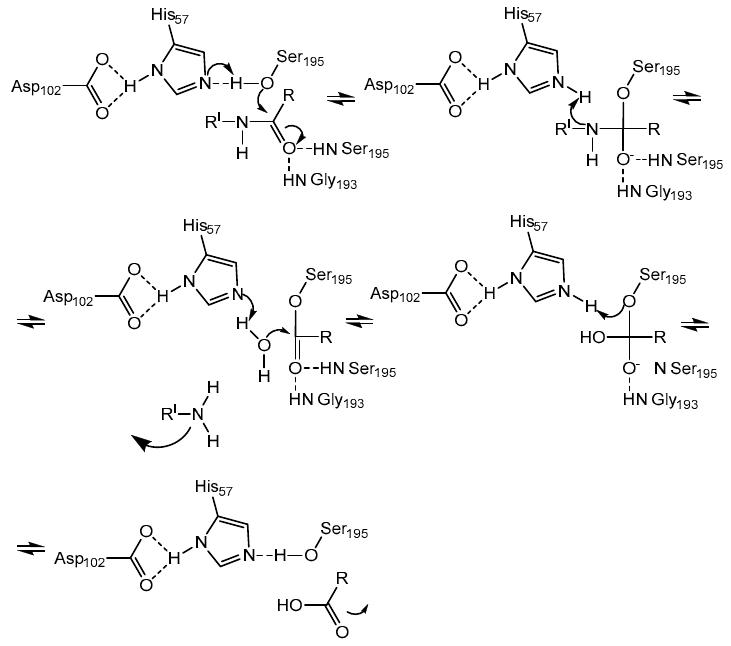
Scheme 1. Mechanism of action of serine proteases